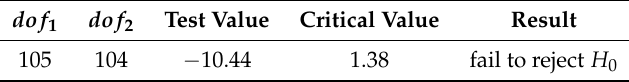
Table 6. Results of F-tests for model complexity (e.g., [35], p. 627). H 0 : more complex parameterization does not provide a significantly improved fit to the data over the single-rate parameterization; H 1 : more complex parameterization provides a significantly improved fit to the data over the single-rate parameterization; dof : denotes degrees of